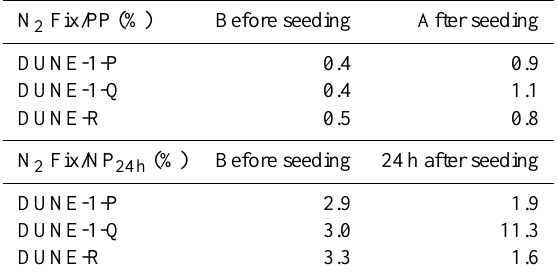
Table 3. Contribution in percentage of N 2 fixation to PP and NP before and after dust seeding in DUNE-1-P, -Q and DUNE-2-R (see details in Material and methods, Sect.